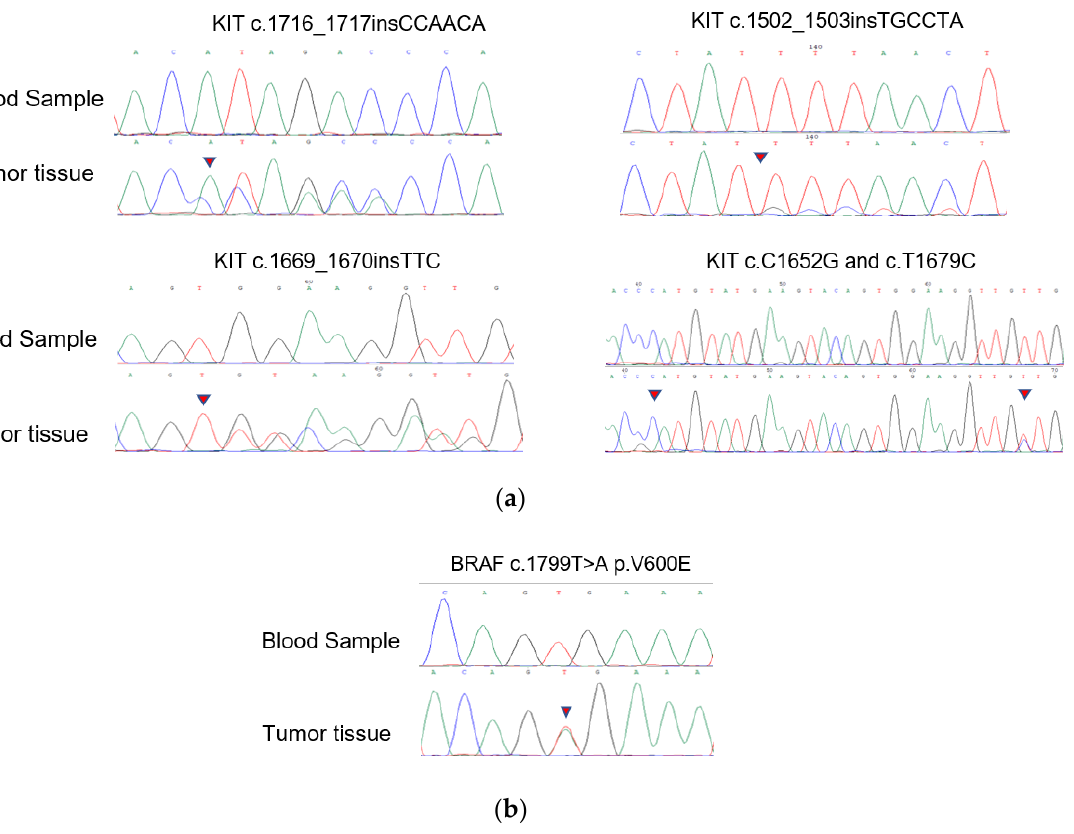
Figure 4. Mutation alleles based on Sanger sequencing. ( a ) Validation of KIT novel mutations using PCR-based Sanger sequencing; ( b ) validation of BRAF mutations using PCR-based Sanger sequencing.